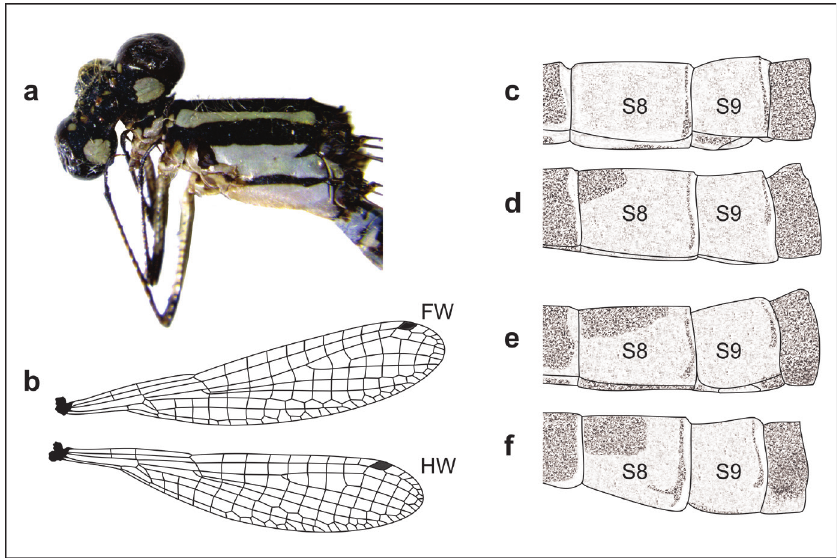
Figure 1. Negragrion sagma sp. n. a: male